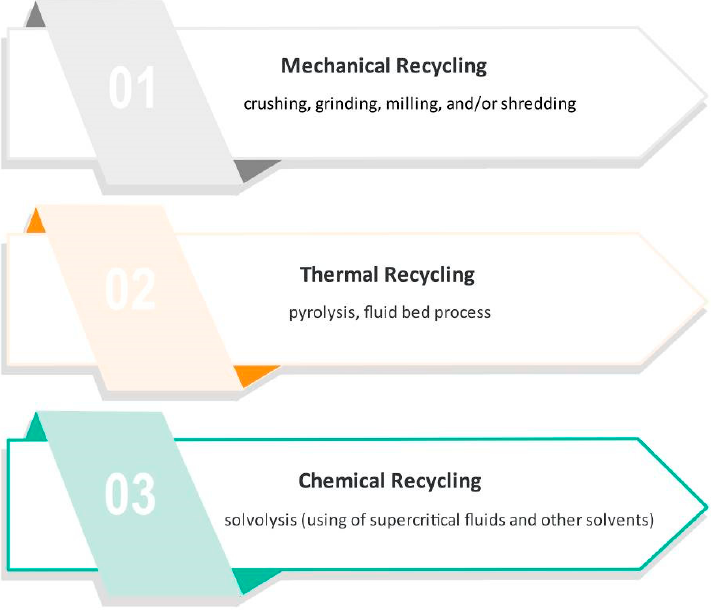
Figure 2. The most usual procedures for recycling carbon fiber-reinforced